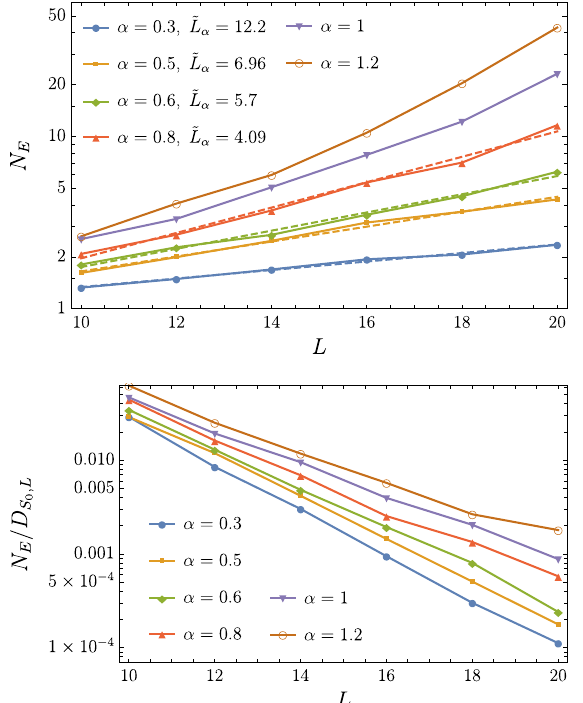
FIG. 3. Statistics of log 10 N (lower). Different curves correspond to different system sizes L ¼ 10 , L ¼ 16 , and L ¼ 20 ; see the legend.